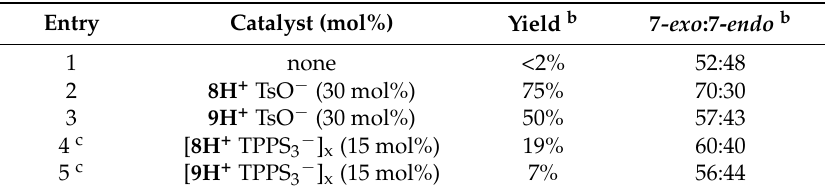
Table 1. Catalysis of the aqueous Diels-Alder reaction by ammonium salts and by TPPS 3 : Amine heteroaggregates (Scheme 2) a.